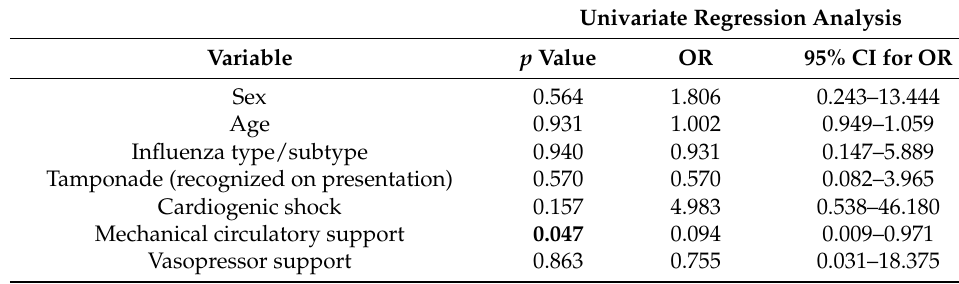
Table 5. Regression analysis in a prediction of patients’